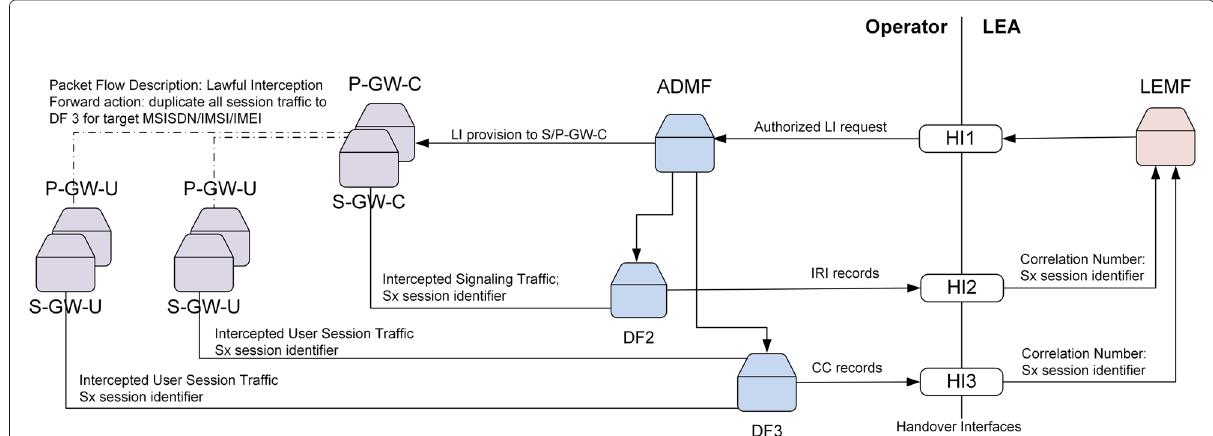
Fig. 8 Modifications in the LI architecture for CUPS support. The essential functionality is preserved for acting on authorized requests from the LEA with adaptions for using the Sx session identifiers as correlation numbers for IRI and